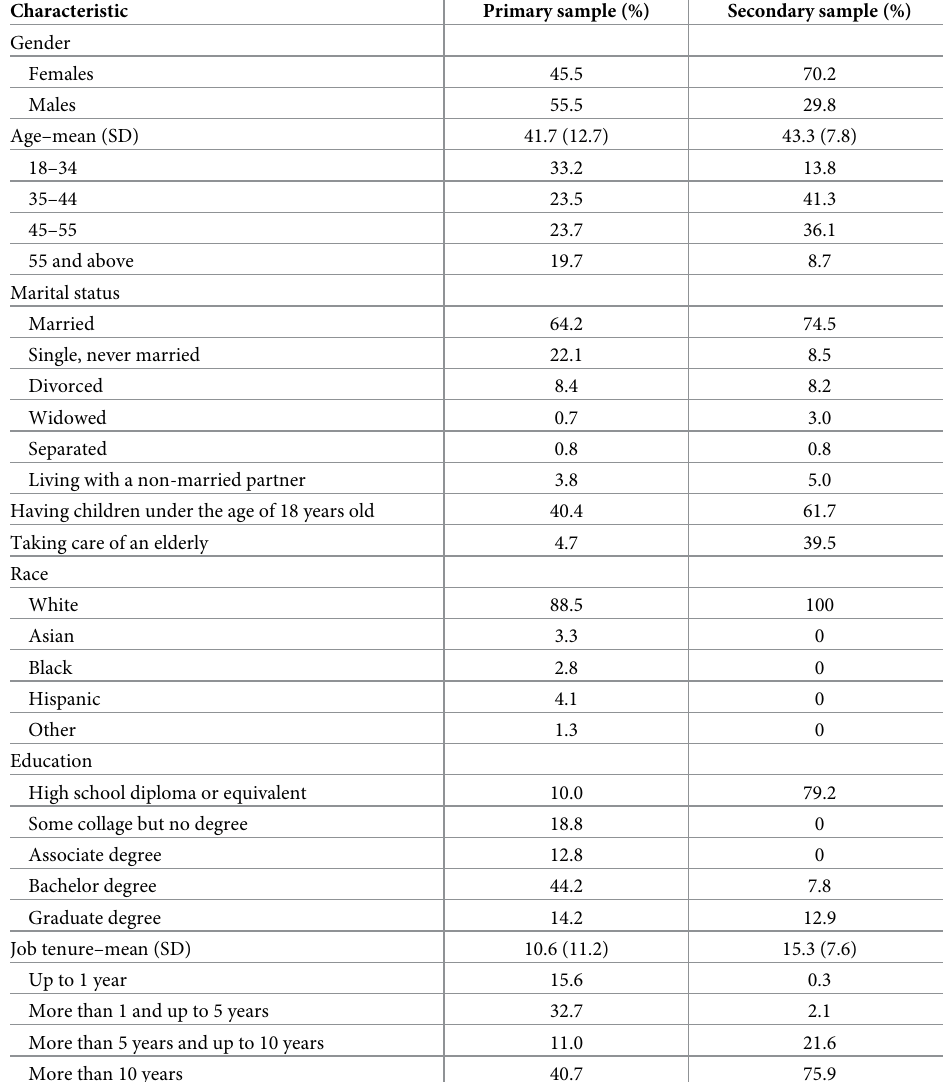
Table 1. Characteristics of participants.